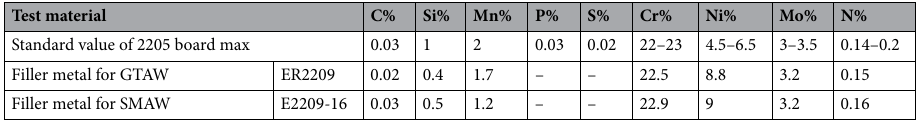
Table 1. The chemical composition of tested steel and filler metal.